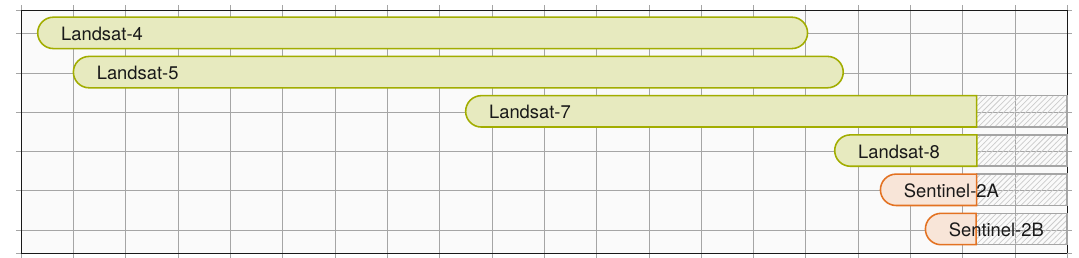
Figure 1. Overview of the used